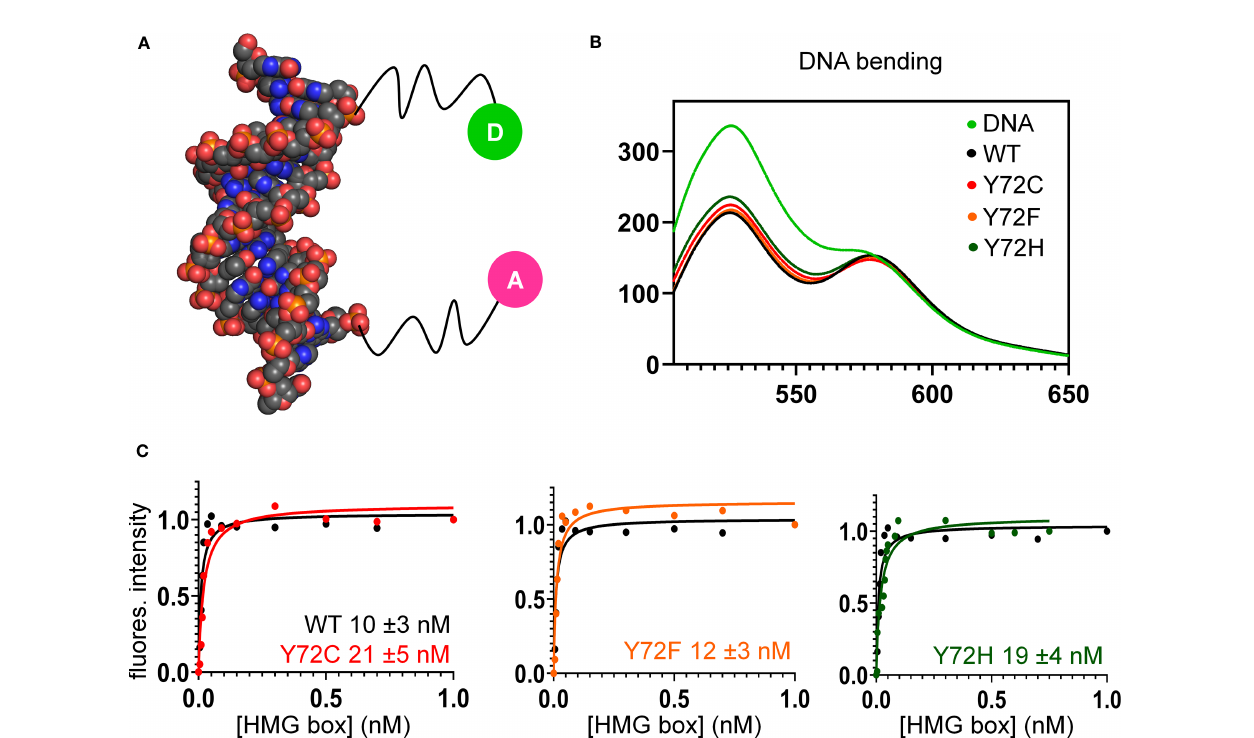
FIGURE 6 | FRET-based equilibrium protein-DNA binding studies. (A) FRET probe: space- fi lling model of DNA (derived from Sox18 co-crystal structure; PDB entry 4Y60) modi fi ed at respective 5 ’ -ends by fl uorescent donor or acceptor, each via a 6-carbon fl exible linker. The donor is fl uorescein (green circle labeled “ D ” ), and acceptor, tetra -methylrhodamine (TAMRA; fuchsia circle labeled “ A ” ) as described (82). (B) Steady-state FRET spectra of WT and variant protein-DNA complexes. On protein-directed DNA bending, donor emission is reduced relative to an unbent protein-free DNA control (light green) due to FRET. (C) FRET-based equilibrium DNA binding studies of the WT and variant domains. In each titration WT data are plotted (black) relative to Y72F (left; orange), Y72C (center; red) and Y72H (right; green). Inferred equilibrium binding constants are inset. These values are robust to kinetic artifacts that can associated with gel mobility-shift assays